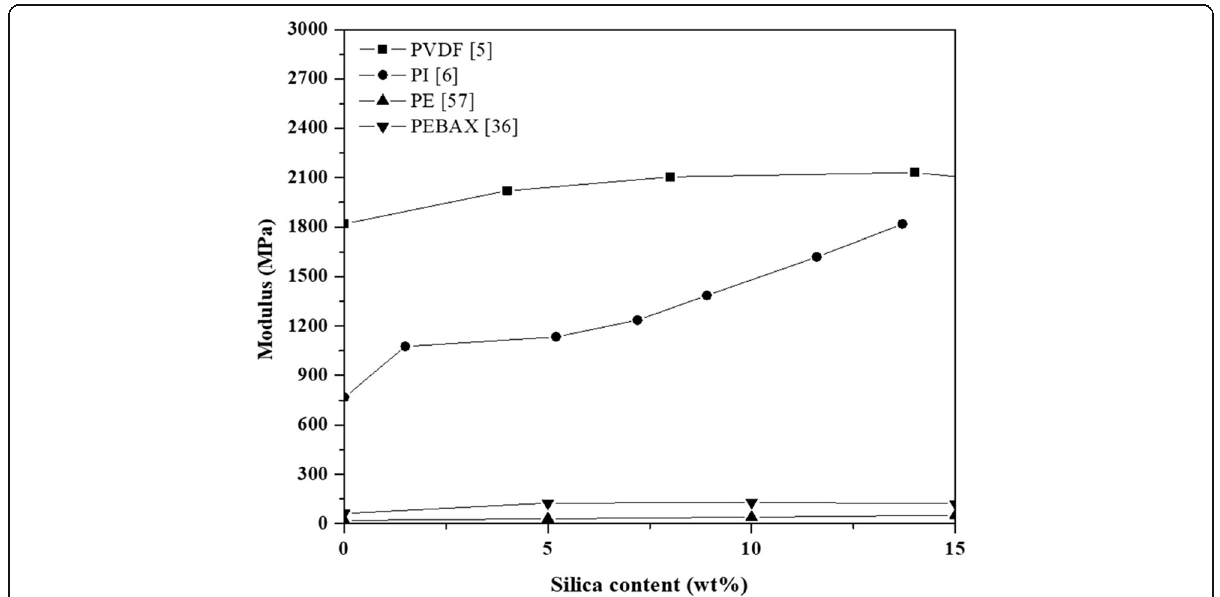
Fig. 12 Tensile modulus of MMMs containing silica (PVDF: polyvinylidene fluoride; PI: polyimide; PE: polyethylene; PEBAX: polyether block